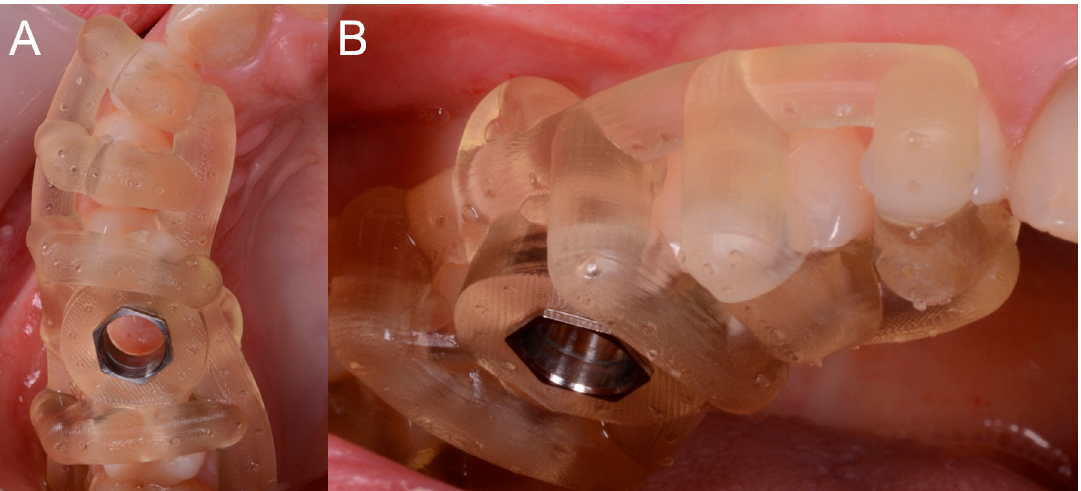
Figure 7. The surgical guide in position with the sleeve inserted in. ( A ) Occlusal view. ( B ) Lateral view.